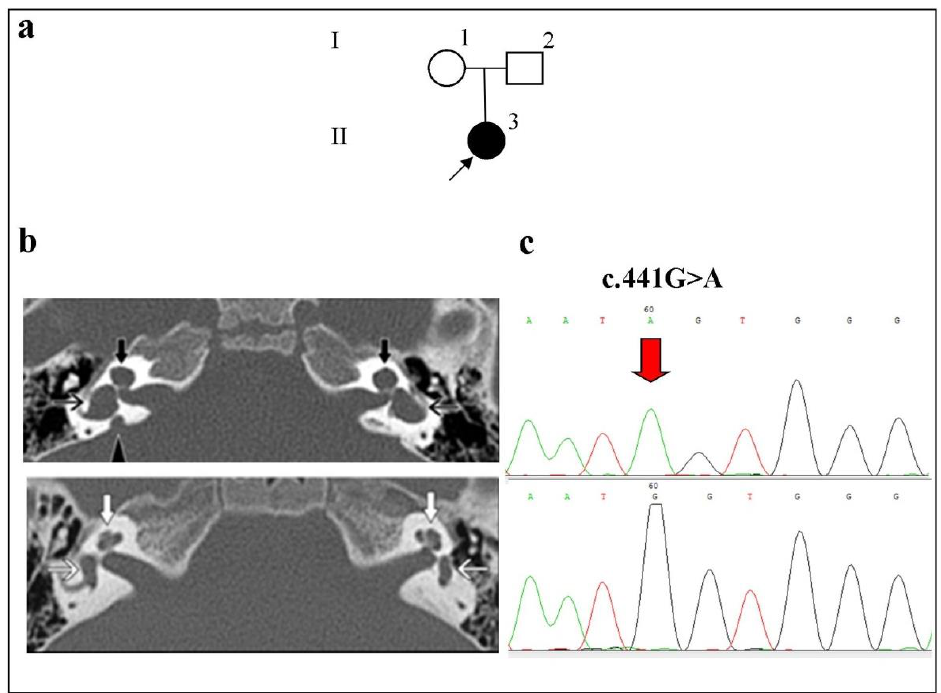
Figure 1. Identification of the c.441G>A p.(Met147Ile) variant in the SLC26A4 gene in a homozygous state in a patient with bilateral IP-1 and unilateral EVA. Note. ( a ) Pedigree of the patient (an arrow indicates the proband). ( b ) Computed tomography (CT) of the temporal bones in the axial projection. Upper panel: Patient II:3 with an IP-1 anomaly (black filled arrows indicate the cystic cochlea), vestibule dilatation (black open arrows), and unilateral EVA (the triangle indicates the enlarged vestibular aqueduct); lower panel, a patient without anomalies (white arrows). ( c ) Upper panel: a fragment of the chromatogram of the SLC26A4 gene sequence with-the identified c.441G>A p.(Met147Thr) variant in a homozygous state; lower panel: the normal